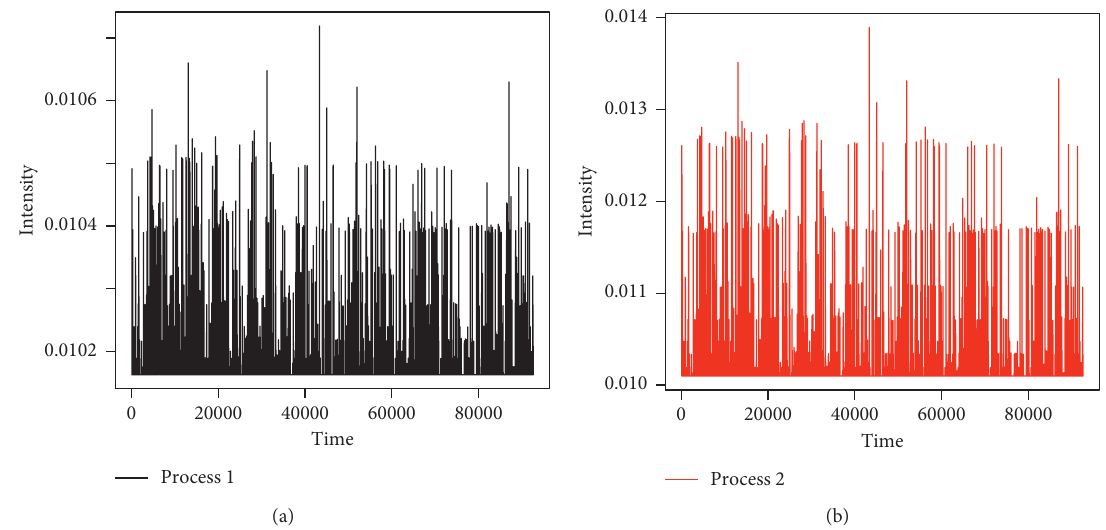
Figure 3: Paths of ground intensity processes of the (a) SH composite index and (b) SZ component index.